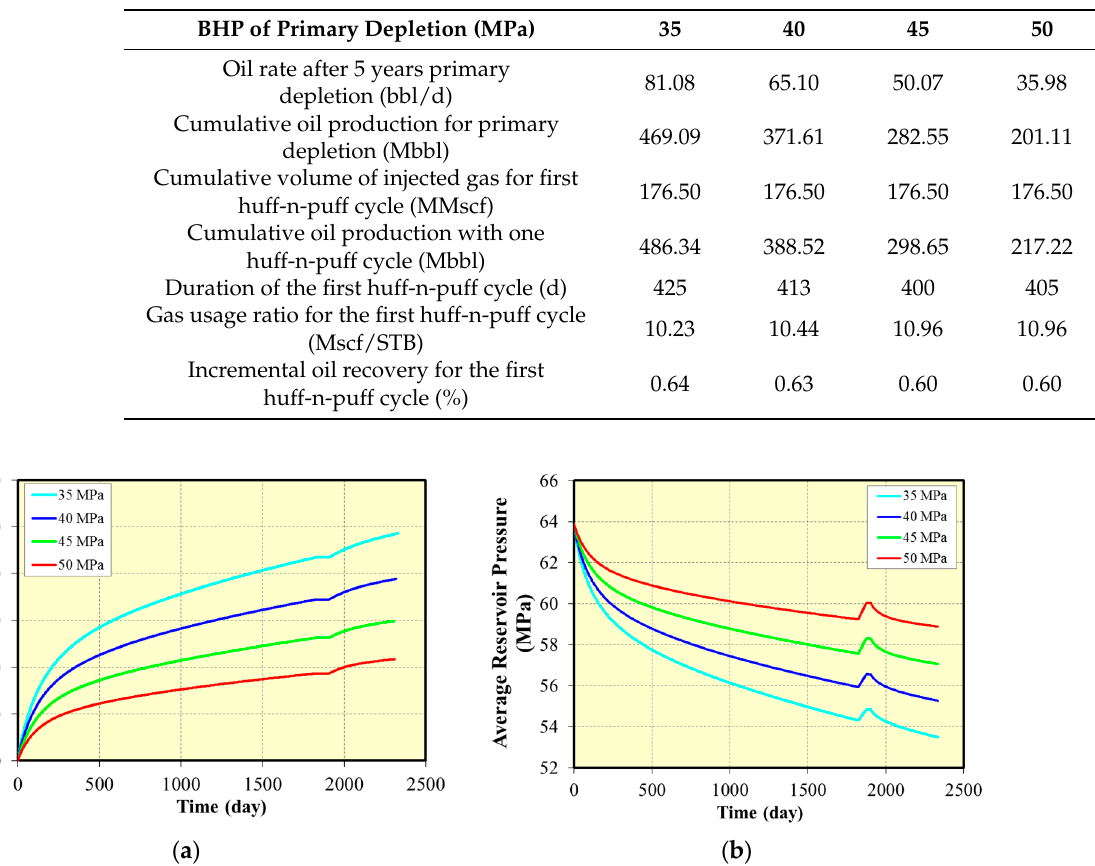
Table 18. Summary of results for huff-n-puff with different bottom hole pressure (BHP) of primary depletion.